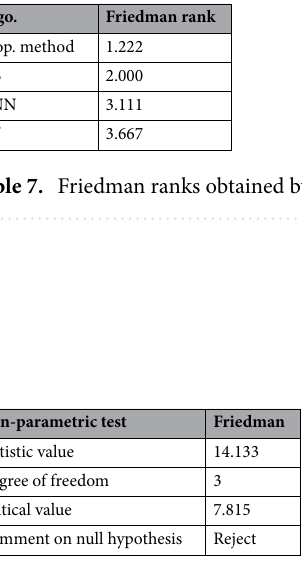
Table 8. Statistical values obtained by Friedman test based on Friedman ranks given in Table